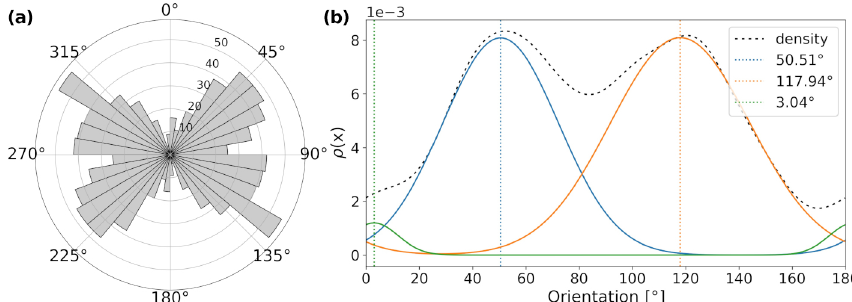
Figure 6. Directional analysis of structural interpretation (Fig. 2a). (a) Rose diagram showing the distribution of strike directions of the structural interpretation with a bin size of 10 ◦ . (b) Gaussian distributions fitted to the probability density function of the strike directions obtained via kernel density